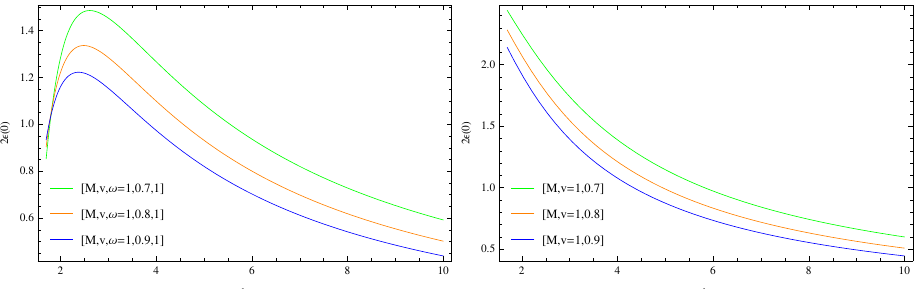
Figure 6. ( left ) Total deflection 2 (cid:101) ( φ ) is shown against φ for different values of the impact parameter b . ( right ) Total deflection 2 (cid:101) ( φ ) is shown against φ for different values of the impact parameter b , for Schwarzschild case.